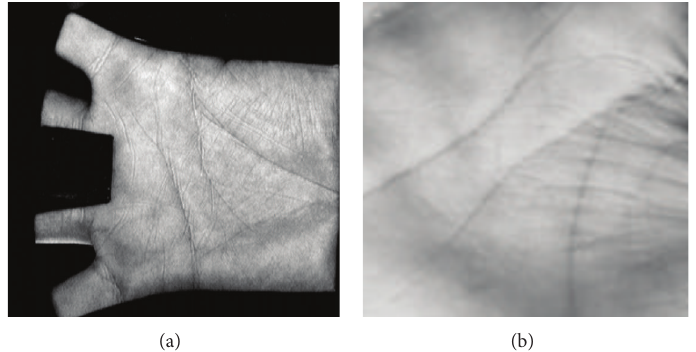
Figure 2: (a) Sample input image. (b) ROI image for PolyU palmprint database.